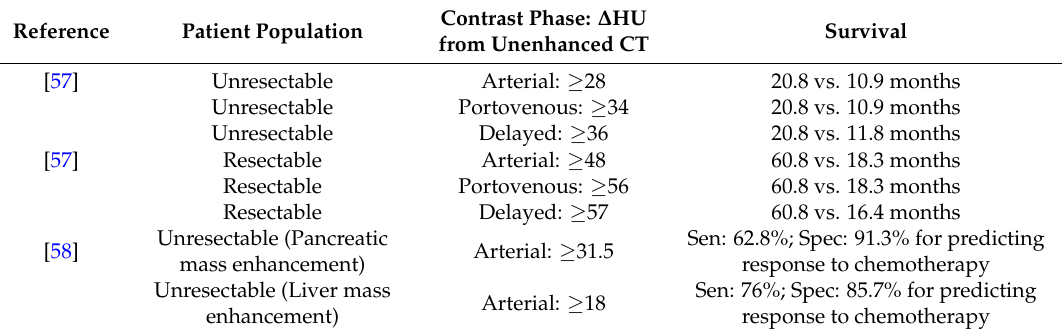
Table 6. Postcontrast enhancement intensity and patient